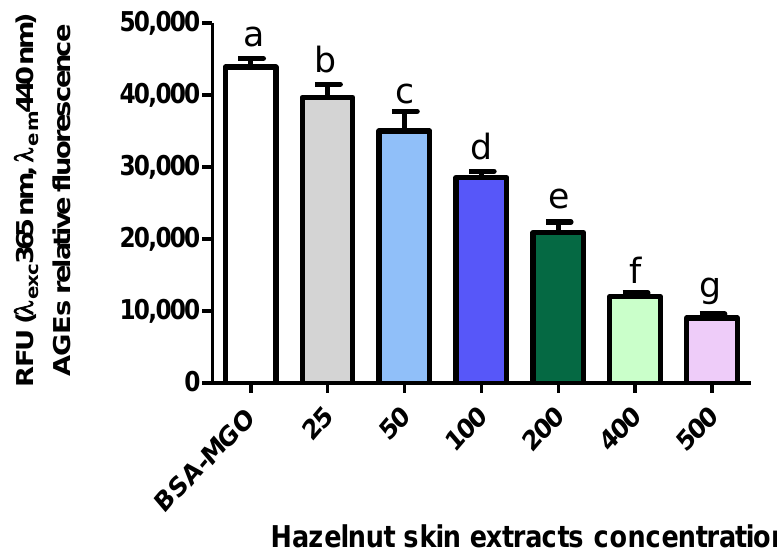
Figure 5. Inhibitory effect on AGE formation. Evaluation of total hazelnut extract (Hz) dose-response effect on AGE formation in vitro. BSA-MGO represents the control group. Different letters represent significant differences among sample (ANOVA one-way and Tukey post-test). Table 4. IC50 value of synthetic or natural compounds: total hazelnut extract, gallic acid, and ami- noguanidine. The concentration required for a 50% inhibition of the intensity of fluorescence (l = 365/440 nm) was calculated from the dose–inhibition curve, obtained by GraphPad analysis ( n = 3). Compounds 109.7 gallic acid 147.6 AG